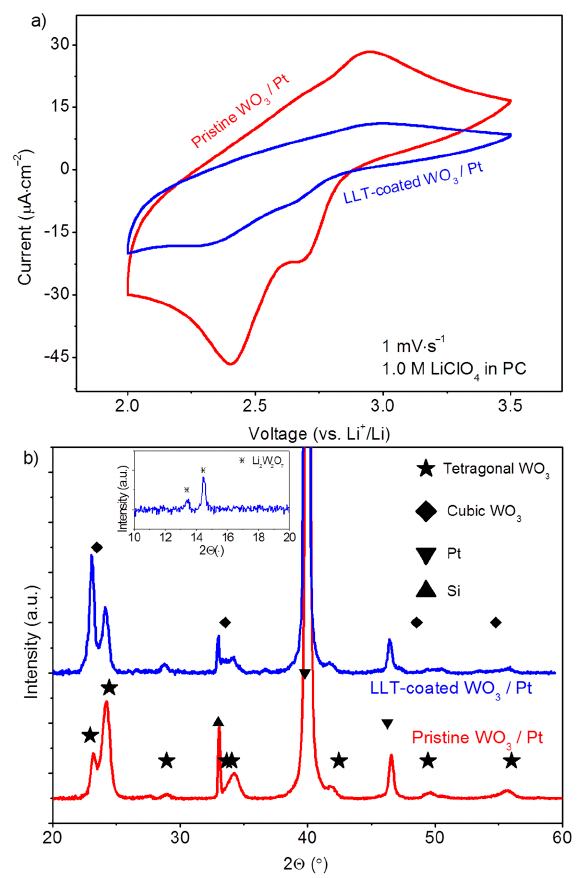
Figure 3. WO 3 -coated planar Pt substrate, annealed at 600 °C for 1 h in static air (red) and LLT-coated WO 3 on a planar Pt substrate (prepared under the same conditions) annealed at 500 °C for 1 h in static air (blue), showing: ( a ) CV of the second cycles; and ( b ) XRD. Tetragonal WO 3 (JCPDS 1-85-807), cubic WO 3 (JCPDS 20-1323), Pt (JCPDS 1-87-647), Si (JCPDS 1-72-1088) and Li 2 W2O 7 (JCPDS 28-598) phases are all indicated.